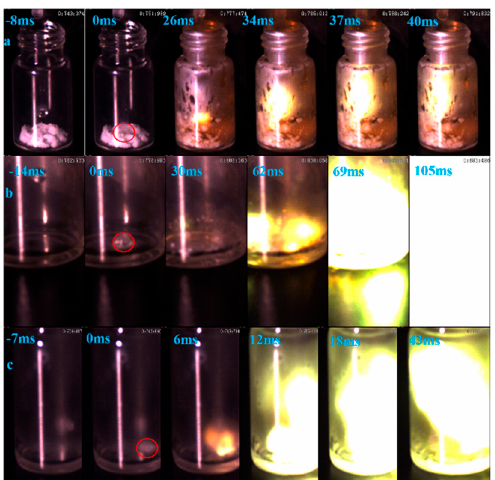
Figure 12. ID of (1-methylimidazolium)(tetrazol-1-yl)borane ( a ); 1-methylimidazole borane ( b ); 20 wt% tetrazole in 1-methylimidazole borane complex ( c ).